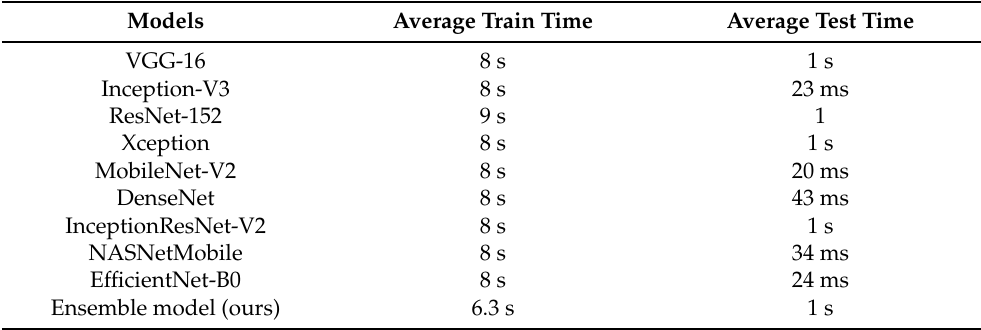
Table 8. Average Epoch time of the training and testing of the proposed ensemble architecture and other fine-tuned